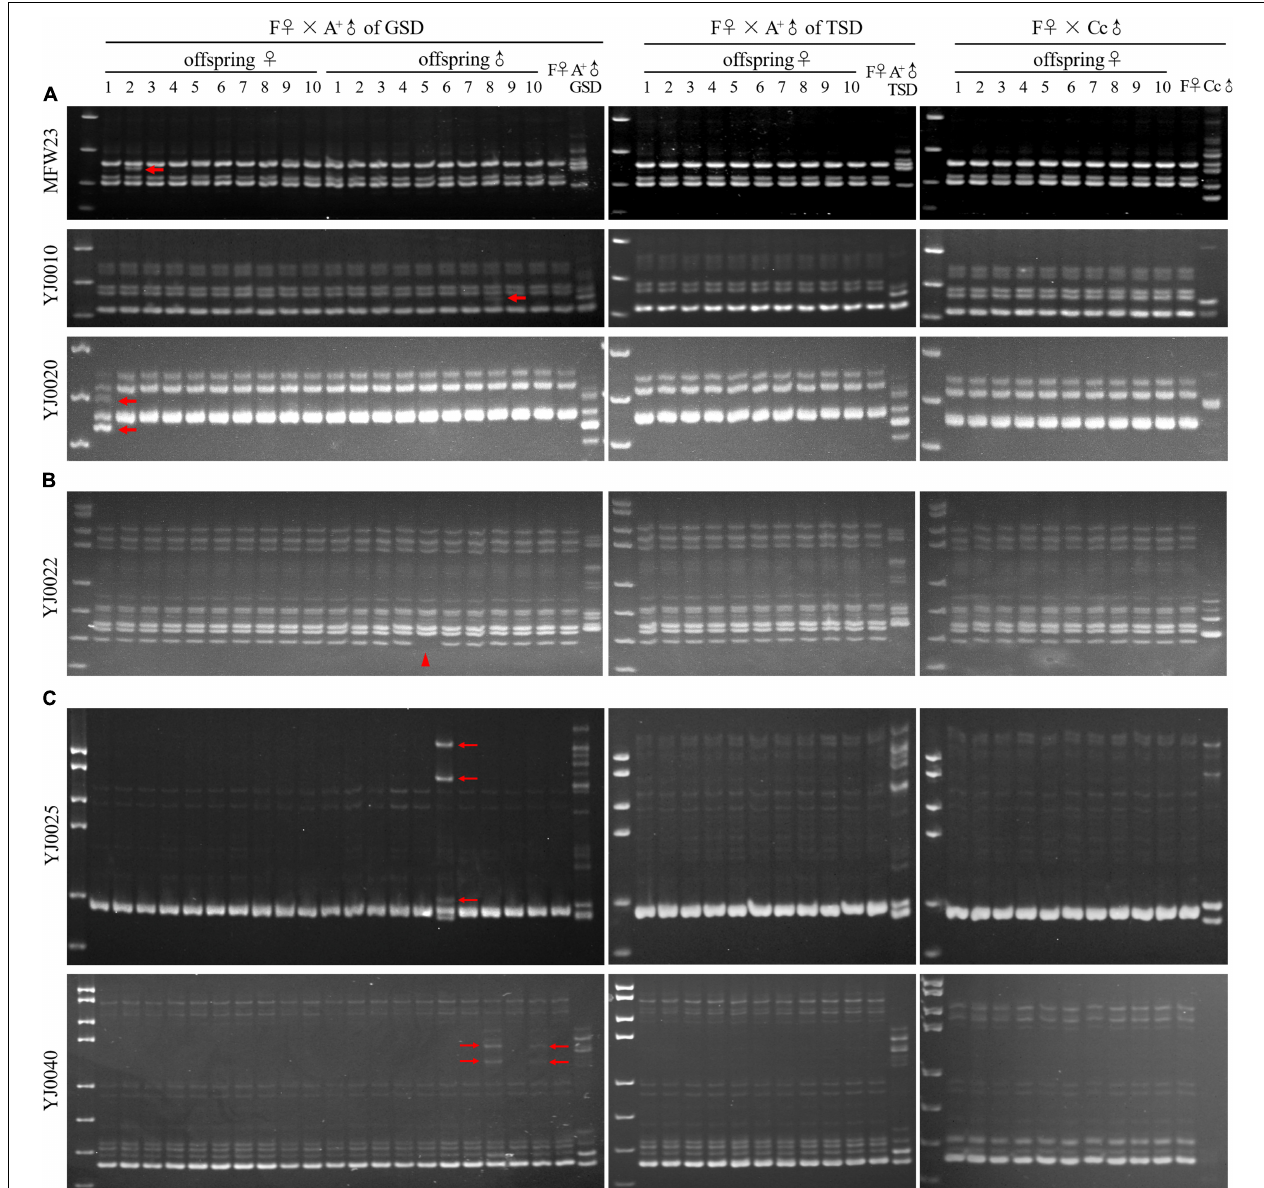
mating with A + of GSD, A + of TSD, and Cc . (A) Microsatellite electrophoretic patterns amplified by the of GSD. (B) Microsatellite electrophoretic ♀ ♂ ♂ ♂ ♂